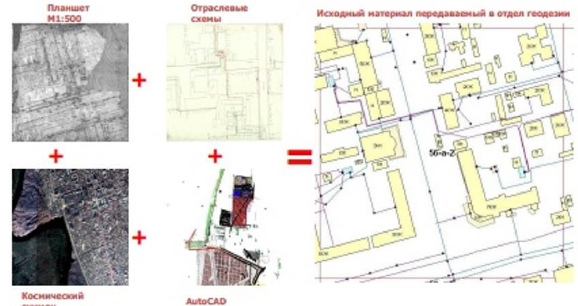
Figure 1. Uralsk Cadastral + Facility Digital Map